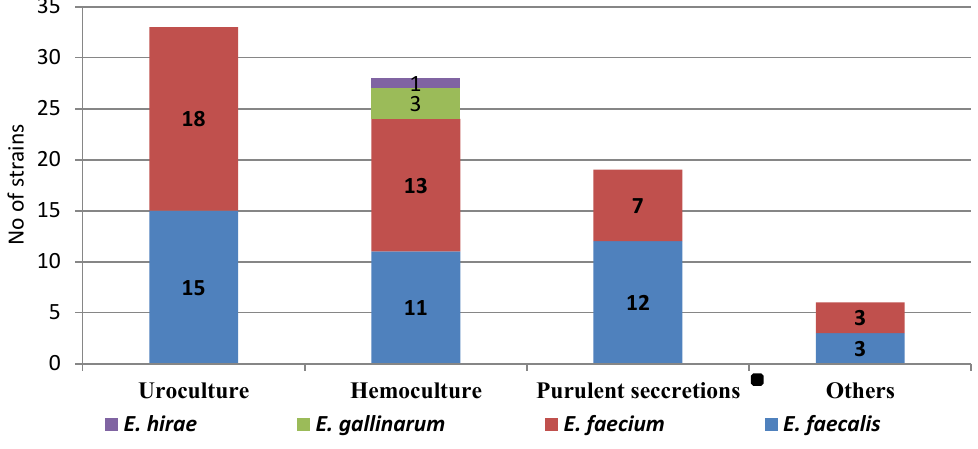
Figure 1. Distribution of Enterococcus spp. isolates according to the type of biologic sample in Galati, Romania.